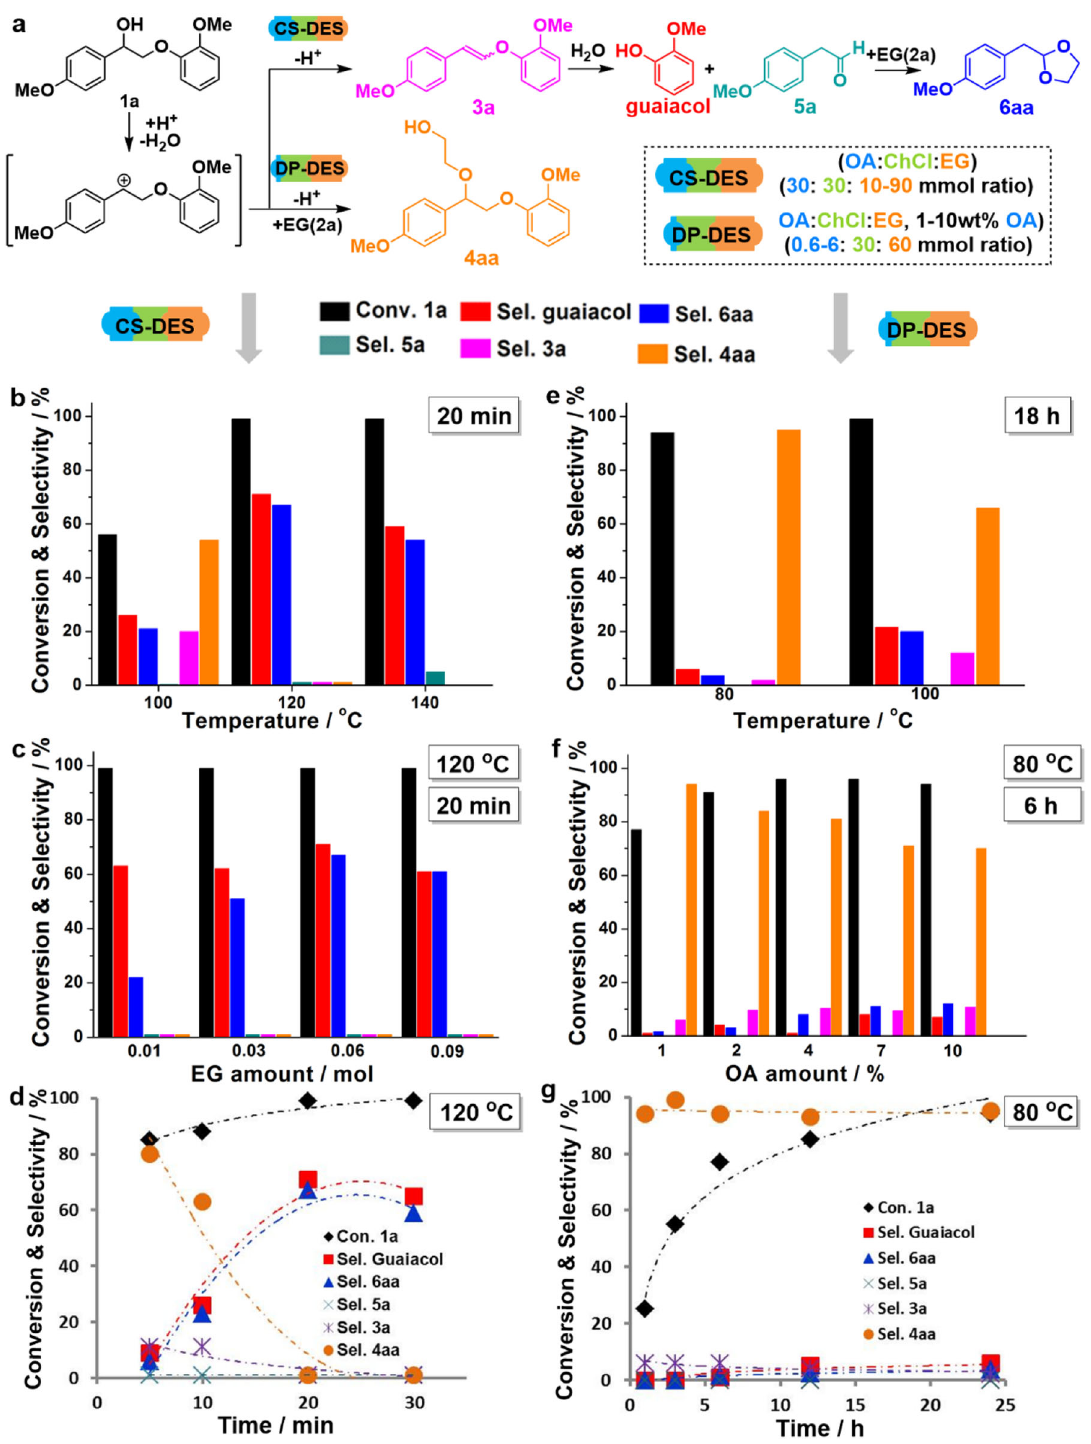
Fig. 3 Development of different DES systems by model compound study. a Reaction pathways during treatment of β -O-4 lignin model compound 1a in CS-DES or DP-DES: the sequence starts with rapid dehydration of 1a . In CS-DES: intermediate 3a is formed; rehydration and cleavage lead to the formation of guaiacol and 5a , unstable 5a is trapped in the form of cyclic acetal 6aa by the ethylene glycol present in CS-DES. In DP-DES: cleavage is suppressed by a controlled amount of OA, 4aa is formed by the attack of ethylene glycol on the carbocation intermediate originating from 1a . Optimization of 1a (25 mg) reaction in CS-DES (ChCl, 4.2 g, 30 mmol: OA, 30 mmol, 3.8 g: EG, 60 mmol, 3.6 g) by b . The temperature of 100 – 140 °C for 20 min; c EG amount (10 – 90 mmol) in CS-DES at 120 °C for 20 min; d Reaction time from 5 to 30 min at 120 °C. Optimization of 1a (50 mg) reaction in DP-DES (ChCl, 4.2 g, 30 mmol: OA, 0.6 mmol, 0.08 g, 1 wt%: EG, 60 mol, 3.6 g). e Temperature of 80 – 100 °C for 18 h; f OA amount (0.6 – 60 mmol, 0.08 – 0.8 g, 1 – 10 wt%) in DP-DES at 80 °C for 6 h; g Reaction time of 1 – 24 h at 80 °C. Conversion of 1a and selectivity of the products were calculated by internal standard calibration with octadecane based on GC-FID analysis; products were identi fi ed by GC/MS; DCM and water were used to extract the products from DESs.